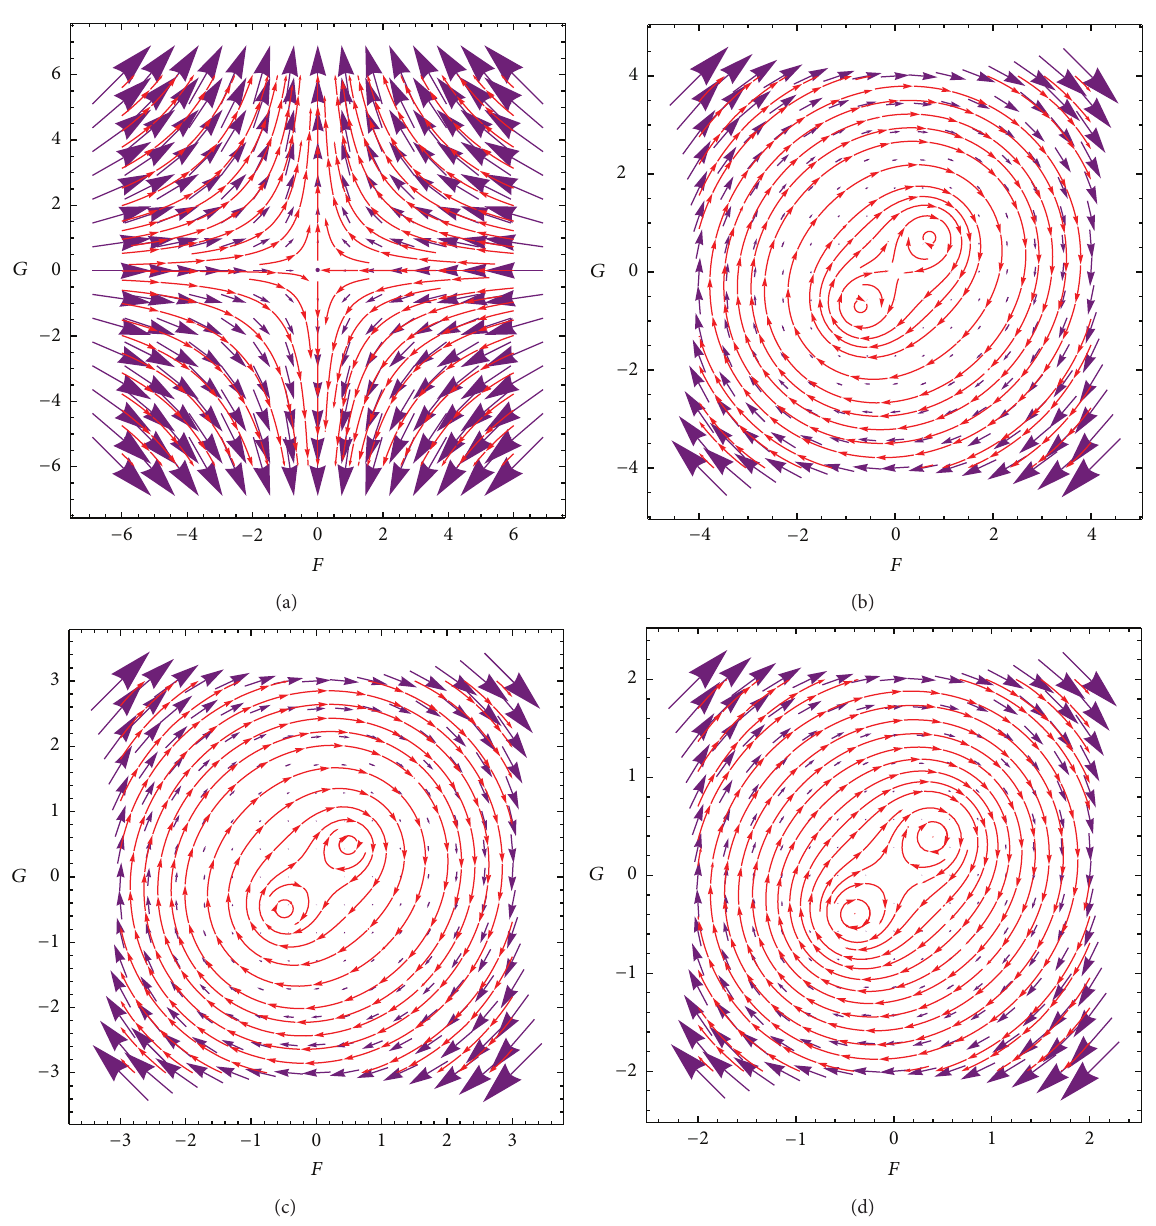
Figure 1: Vector field display of TNDES for (a) 𝛽 = 0 , (b) 𝛽 = 0.5 , (c) 𝛽 = 1 , and (d) 𝛽 = 1.5